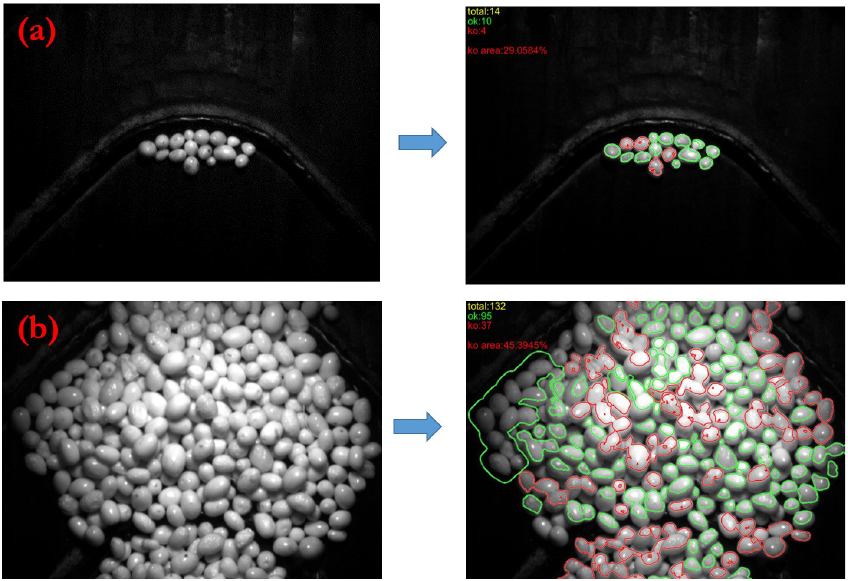
Figure 9. Defect detection. ( a ) Figure 7 defective olives detection. ( b ) Figure 8 defective olives detection.